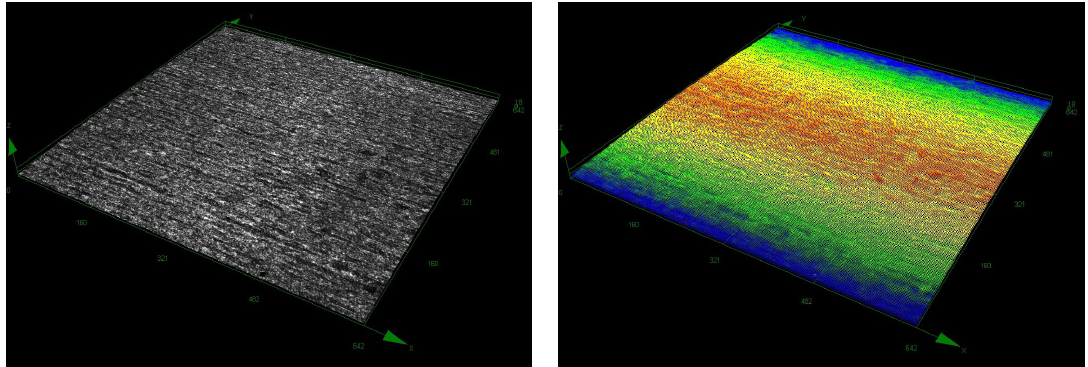
Figure 6. Surface microscopic image of smooth Inconel